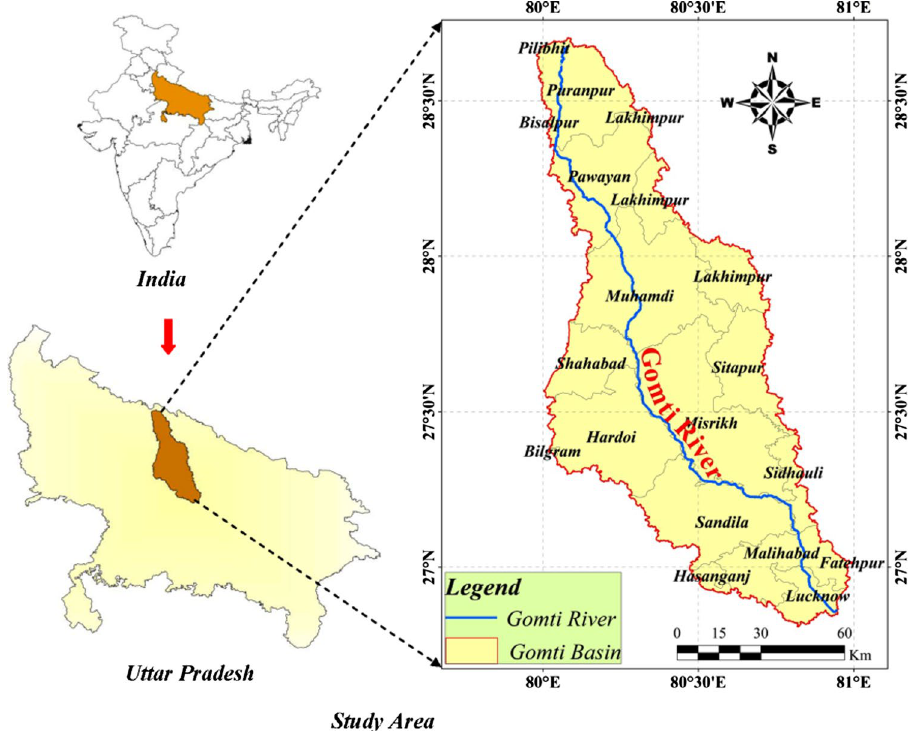
Fig. 1 Location map of the Gomti